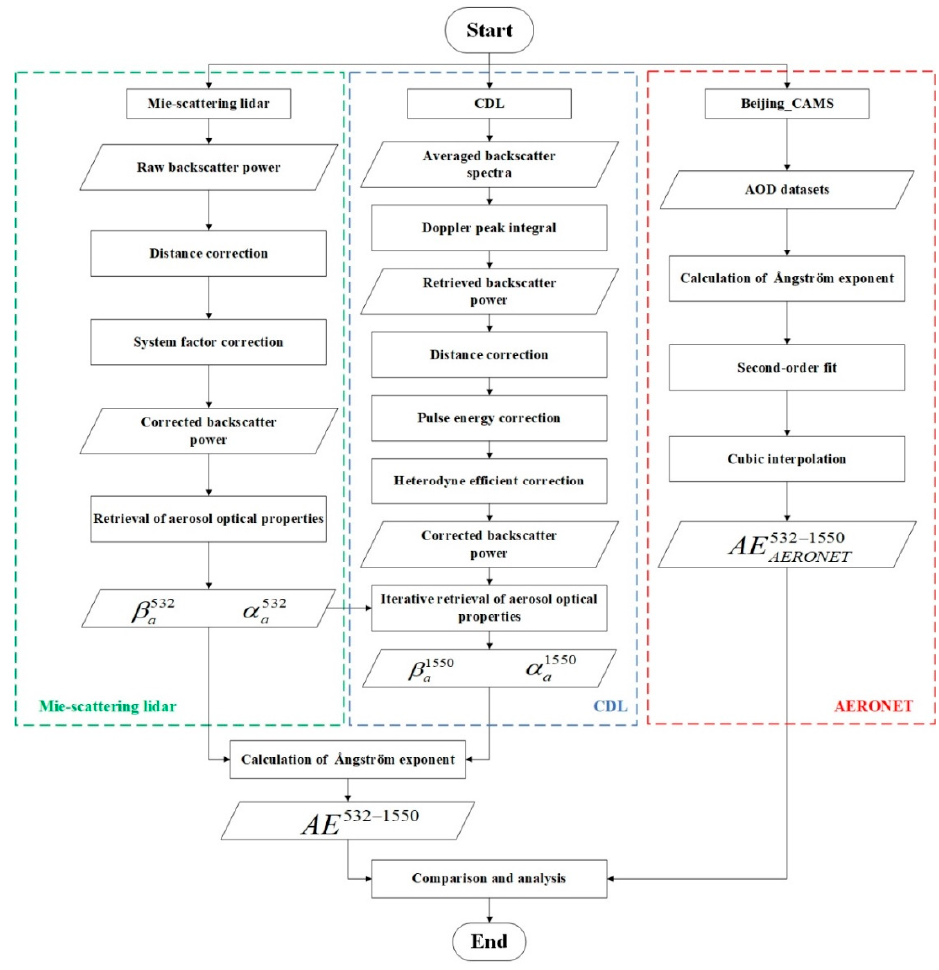
Figure 2. The flowchart shows the retrieval and verification procedures of aerosol optical properties with Mie-scattering aerosol lidar.